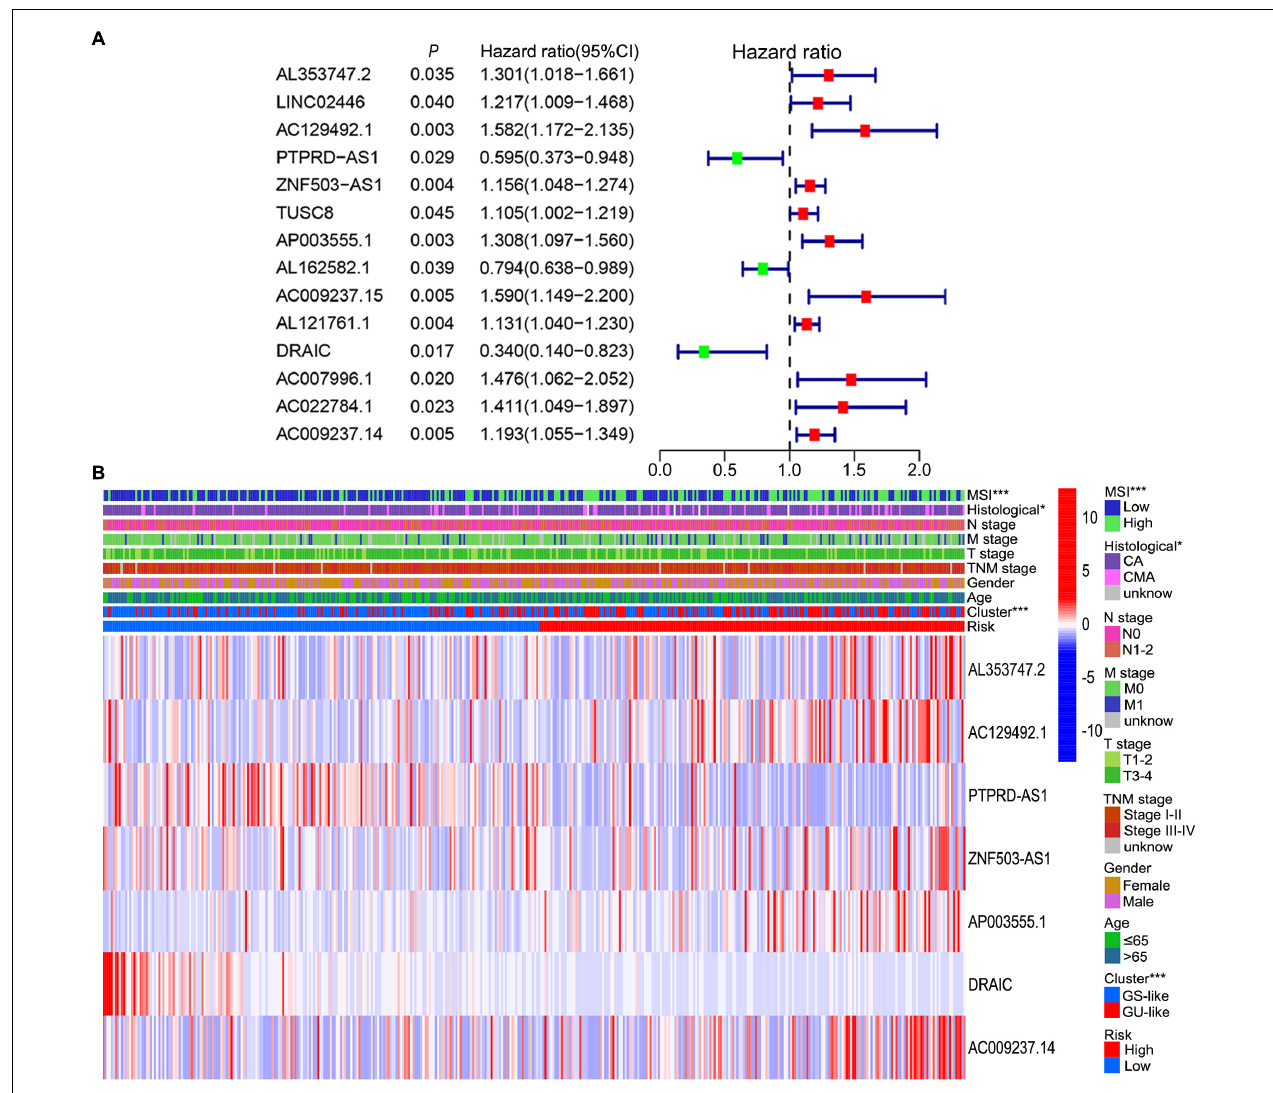
FIGURE 4 | Prognosis-related lncRNAs and correlation of prognostic risk score with clinicopathological features. (A) Forest plot of 14 prognosis-related lncRNAs after univariate Cox regression analysis in training set. The red points represent risk lncRNAs with a mean hazard ratio larger than 1, while the green points represent protective lncRNAs with a mean hazard ratio less than 1. The blue bar indicates the 95% CI of the hazard ratio. (B) Relationship among prognostic risk, MSI, genome instability cluster, clinicopathological characteristics and expression level of seven lncRNAs in the signature in TCGA set. CI, confidence interval; MSI, microsatellite instability; CA, colon adenocarcinoma; CMA, colon mucinous adenocarcinoma; GS-like, genome stable-like; GU-like, genome unstable-like; * P value < 0.05; *** P value < 0.001.